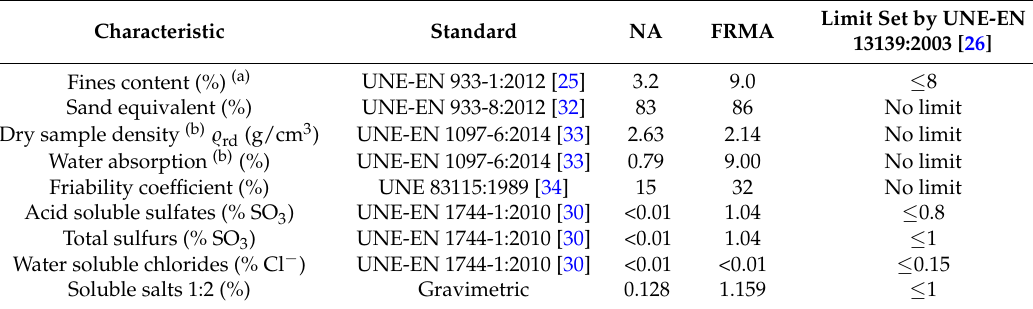
Table 3. Characterization of NA and